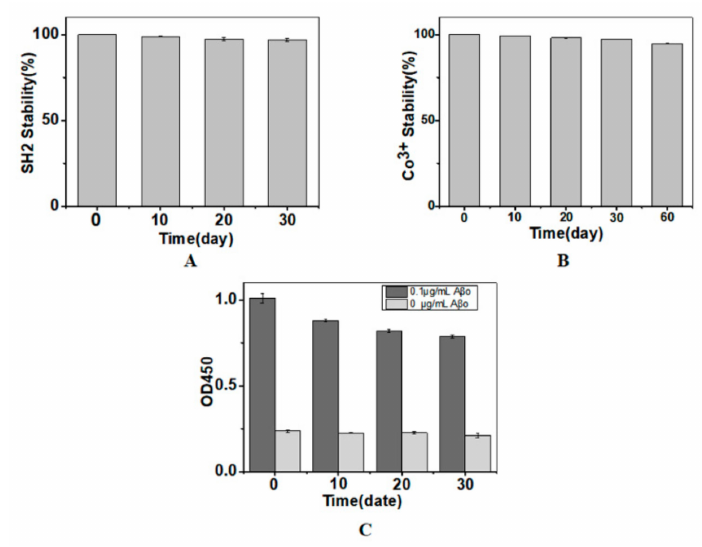
Figure 4. Release of SH2 ( A ); release of Co 3 + ( B ); and the immuno-activity of SH2 ( C ) during storage. Total amount of the nanobody or Co 3 + and the immune-activity of the nanobody detected immediately after SH2 immobilization were considered as 100% ( n =